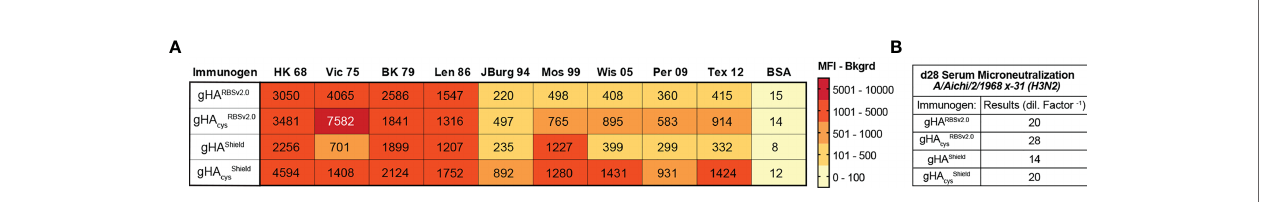
FIGURE 5 | gHA immunogens elicit serum responses with limited breadth and neutralization. (A) Day 28 serum binding against a Luminex panel of antigenically distinct, historical H3 HAs spanning 1975-2012. Serum responses show limited breadth beyond H3Leningrad/360/1986 (x-91) (Len 86). Serum binding is reported as the average mean fl uorescence intensity (MFI) minus background for all mice in a speci fi c cohort. (B) Microneutralization of day 28 serum against matched A/ Aichi/2/1968 X-31 (H3N2) virus. Endpoint titers are reported as the greatest dilution observed to exhibit ≥ 50% virus neutralization and are reported as geometric mean of duplicate dilution series. Day 28 serum from each immunogen show weak microneutralization of